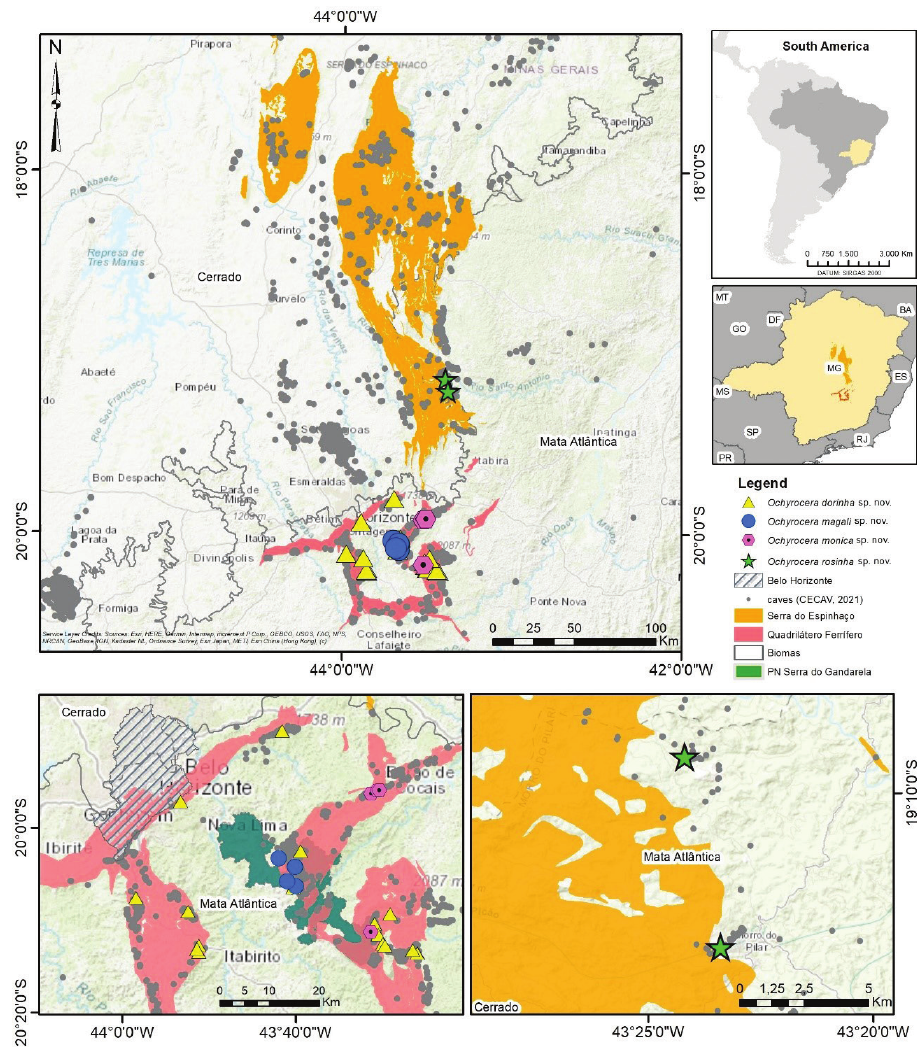
Figure 14. Distribution map of the four new species of Ochyrocera from the state of Minas Gerais (MG), Brazil: O. dorinha sp. nov. (yellow triangles), O. magali sp. nov. (blue circles), O. monica sp. nov. (pink circles), and O. rosinha sp. nov. (green